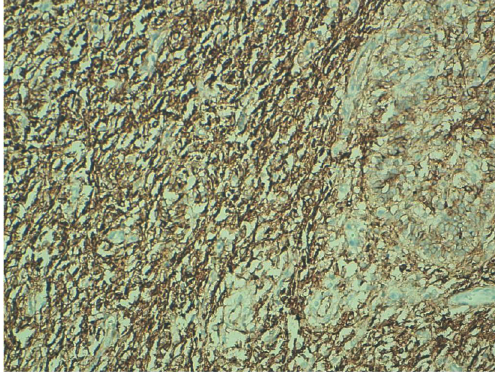
Figure 3: Microscopic finding: standard coloration (HES). a well-circumscribed endometrial stromal tumor; however, focal irregularities or finger-like projections into the adjacent myometrium are acceptable if none of them exceed 2 to 3 mm [8, 9].